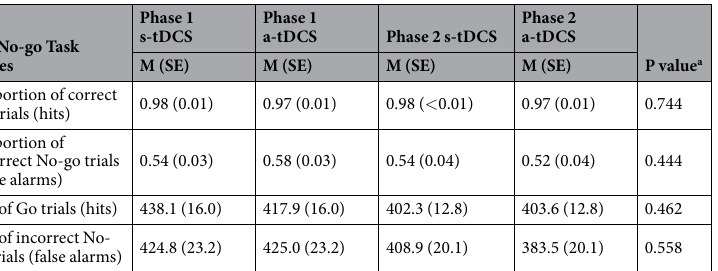
Table 6. Go No-go Task scores according to Group and Phase (n = 35). Notes: s-tDCS = sham stimulation group; a-tDCS = active stimulation group; RTs = reaction time (in milliseconds). a Refers to the F statistics for the interaction term between Group and Phase. No main effects were found for Group or Phase in any